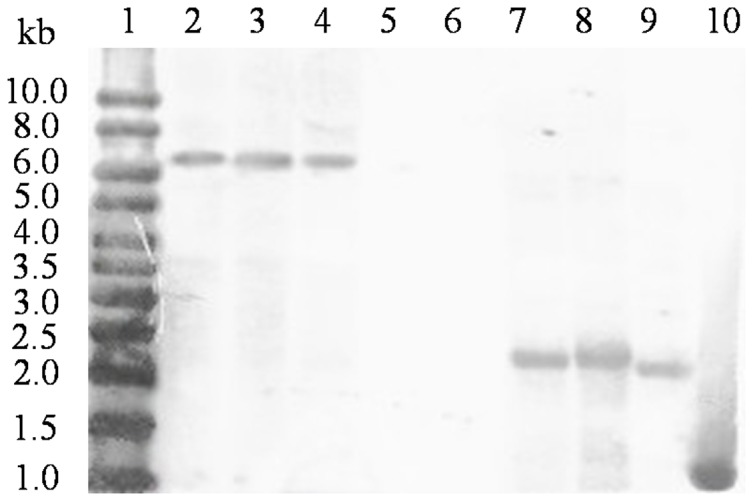
Southern blot analysis of MAN5AS in three transgenic plants of event 22 after digestion with HindIII and BamHI.Lane 1, the DIG-labeled molecular weight markers; lane 2–4, MAN5AS with BamHI digestion; lane 5 and 6, non-transgenic Zheng58 digested by BamHI and HindIII, respectively; lane 7–9, MAN5AS with HindIII digestion; lane 10, the digested expression cassettes as a positive control.